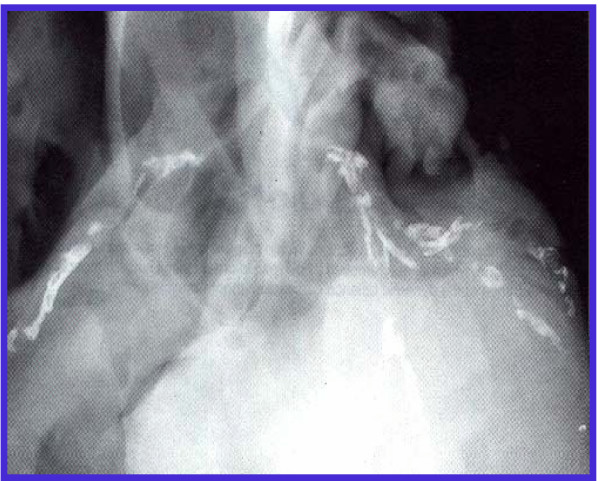
Coronary artery calcification. This image demonstrates coronary artery calcification. This 68 year-old Caucasian male with CAD, congestive heart failure and angina was found at autopsy to have a complete occlusion of the LAD with thrombus. Known T2DM of 8 years duration and Htn of 10 years duration with normal CA++ and Pi, BUN 32 mg/dL, creatinine 1.8 mg/dL, proteinuria trace to +1, total cholesterol 198 mg/dL, and triglycerides 398 mg/dL